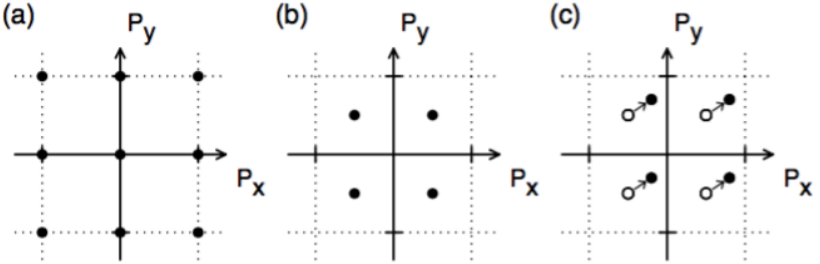
Figure 5: (a) and (b) The two possible 2D polarization lattices that are consistent with 2D square lattice symmetry. They correspond to the 2D projections of BaTiO and KNbO respectively. Note that for ‘(b)’ zero is not a possible polarization. (c) A 3 change in polarization induced by some symmetry-lowering change of the Hamilto- nian. Adapted from Ref. [ 28 ]